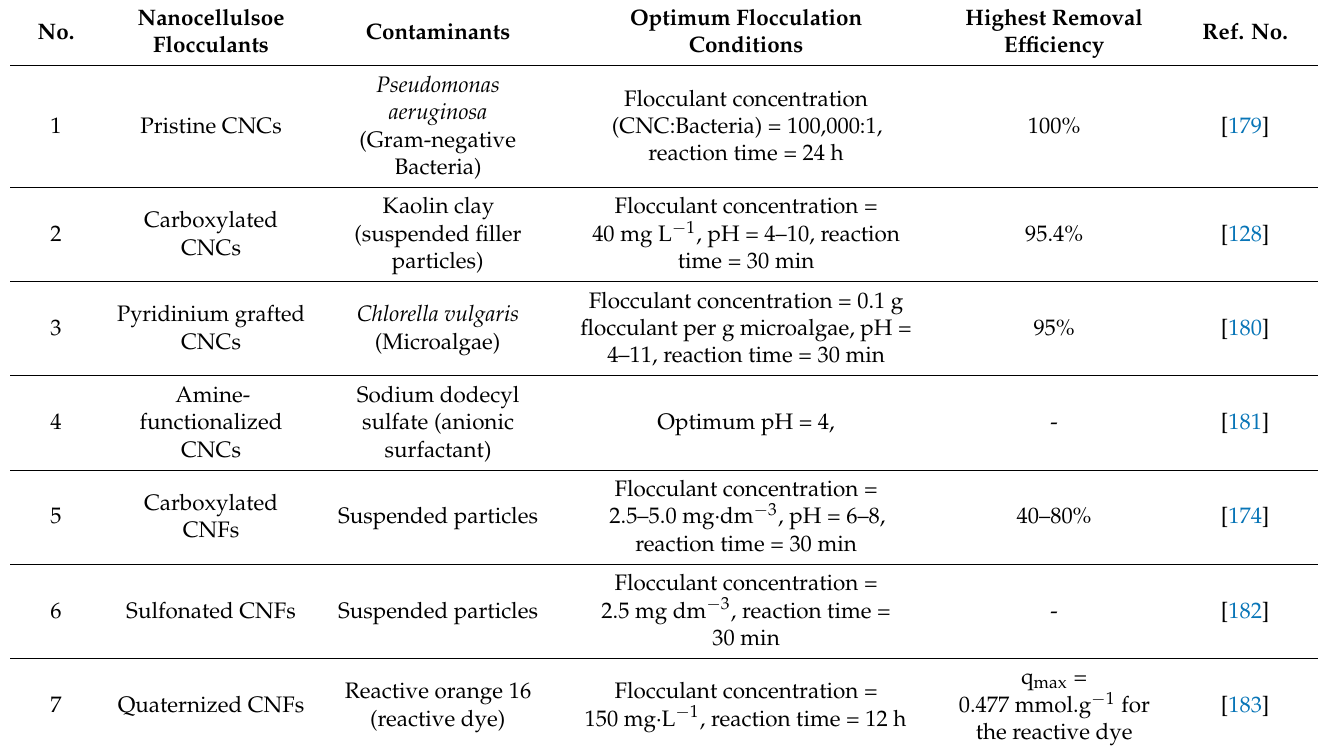
Table 5. Various nanocellulsoes-based flocculants used for the water treatment